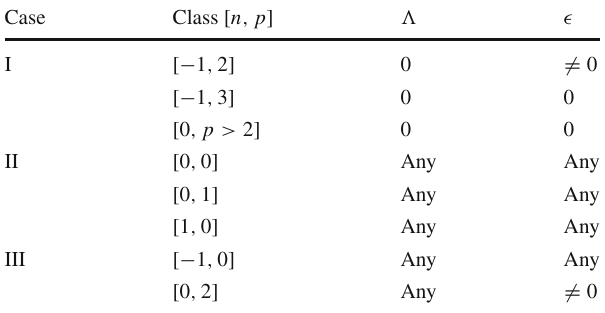
Table 1 Values of [ n , p ] compatible with indicial equations following from (32)–(34).Certainfurthercasesallowingonlyfordiscretenonzero values of (cid:2) are not included in the table. See [16,17,19,20] for details in the case (cid:9) = +